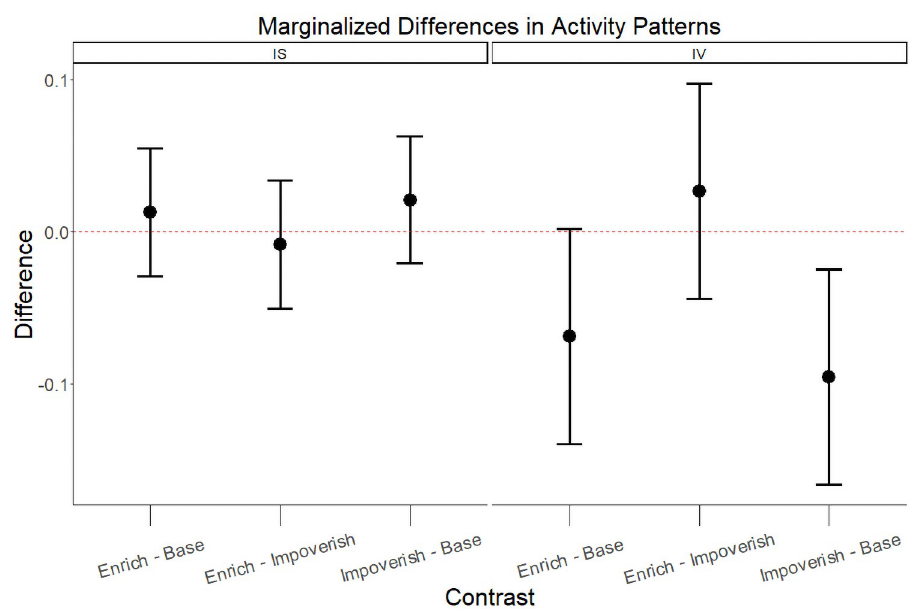
Fig 4. Marginalized differences in activity patterns between experimental conditions. The estimated mean difference in Inter-Daily Stability (IS) and Intra-Daily Variability (IV) of lemur activity patterns between experimental condition, marginalized over estimated effects of experimental order. Error bars represent two standard errors of the estimated population mean difference for the given contrast.